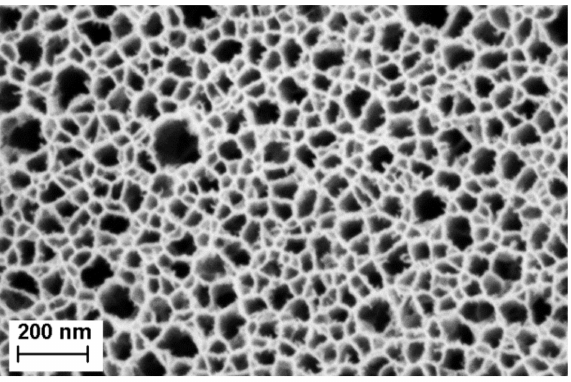
Figure 3. Scanning electron microscopy (SEM) image of the top layer porous silicon membrane. The average pore size is ~41 nm, with a standard deviation of ~20 nm.